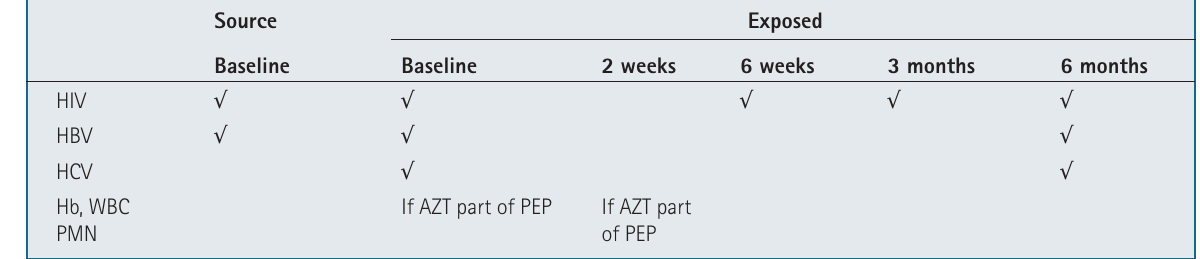
tabLe i. timinG oF bLooDS Pre- anD PoSt